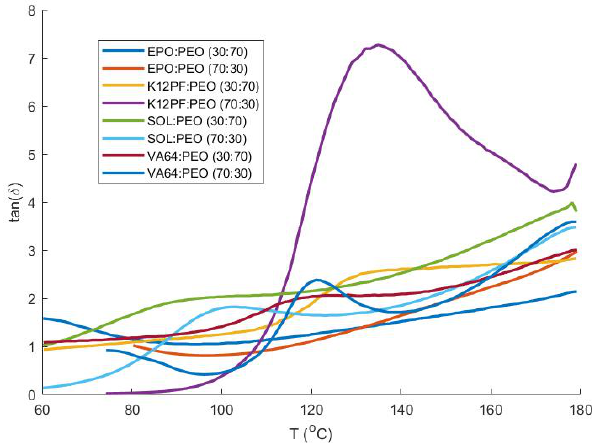
Figure 8. Dynamic temperature sweep of the loss tangent (tan δ ) for all placebo blends, indicating a large peak in the Kollidon 12PF:PEO blend